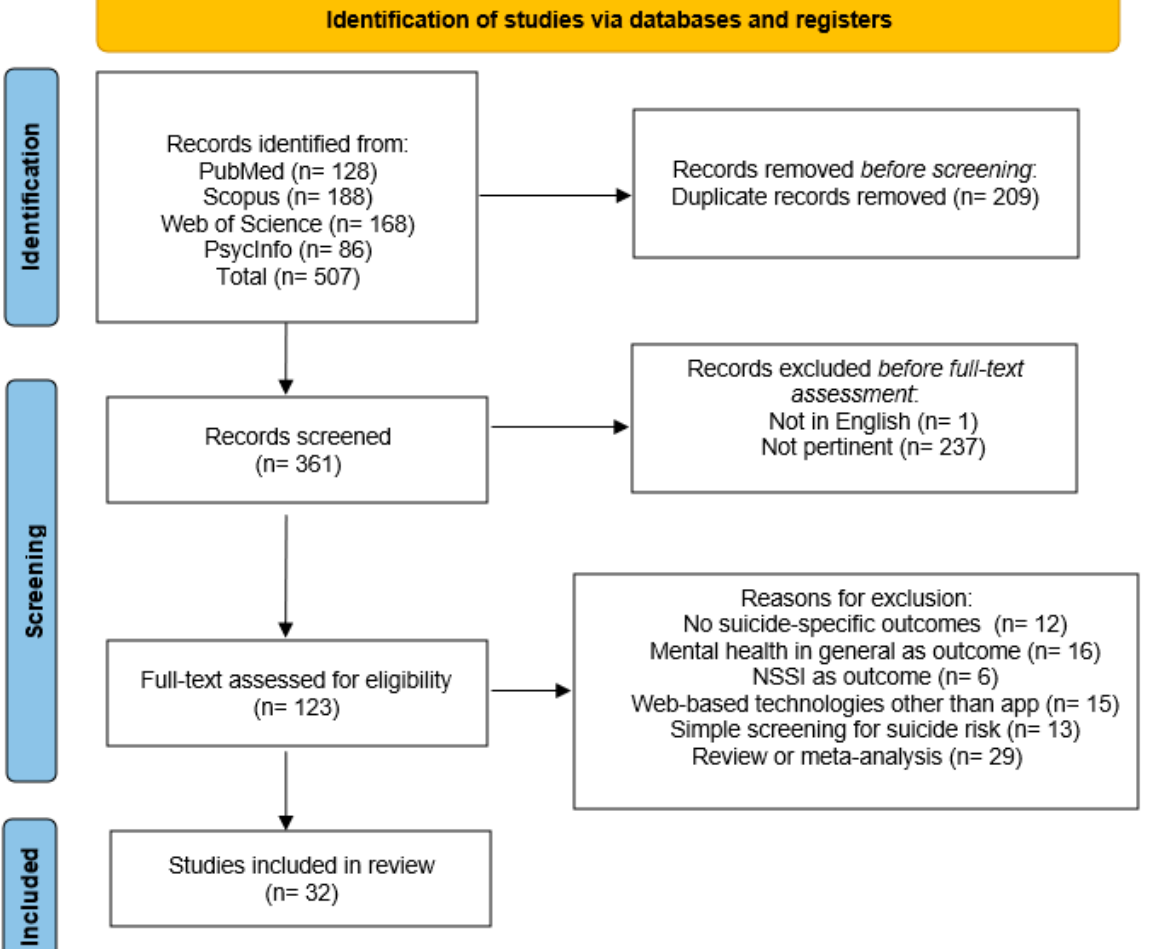
Figure 1. PRISMA flowchart. PRISMA, Preferred Reporting Items for Systematic Reviews and Meta-Analyses [26].